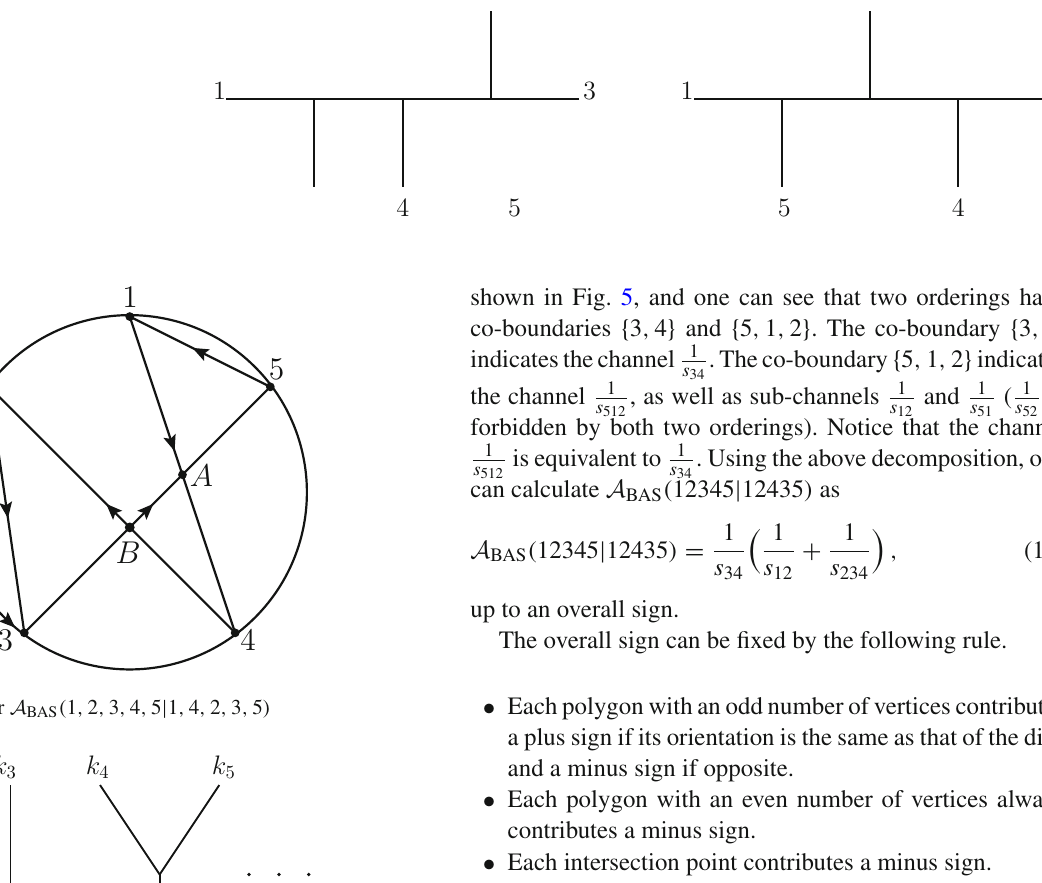
Fig. 2 Two 5-point diagrams